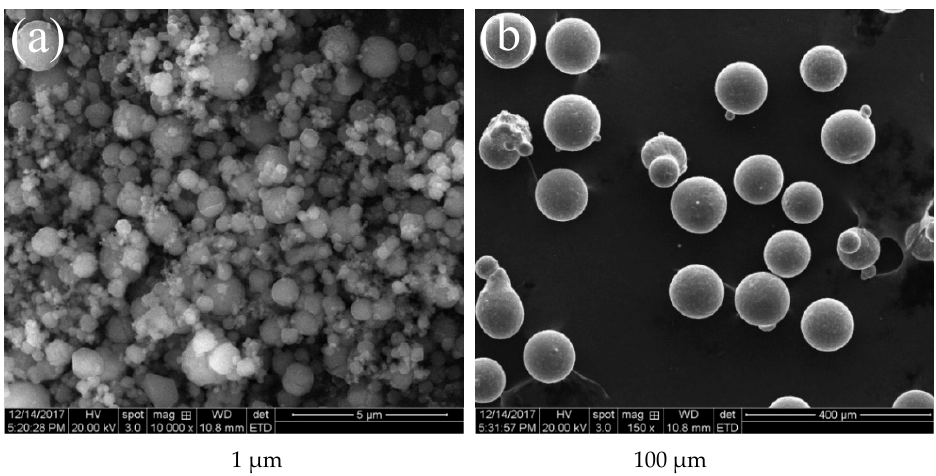
Figure 8. Scanning Electron Microscopy (SEM) images of small ( a ) and large ( b ) magnesium particles.